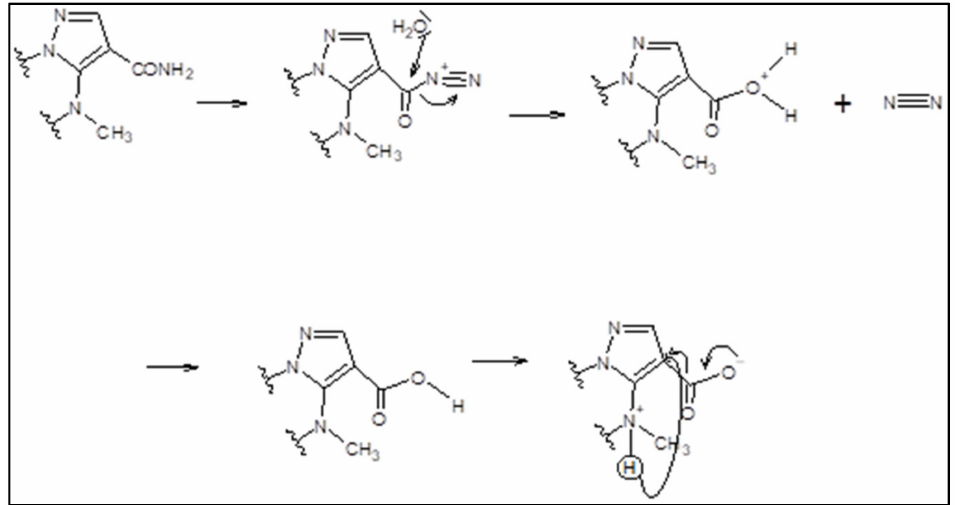
Figure 5. A possible mechanism of